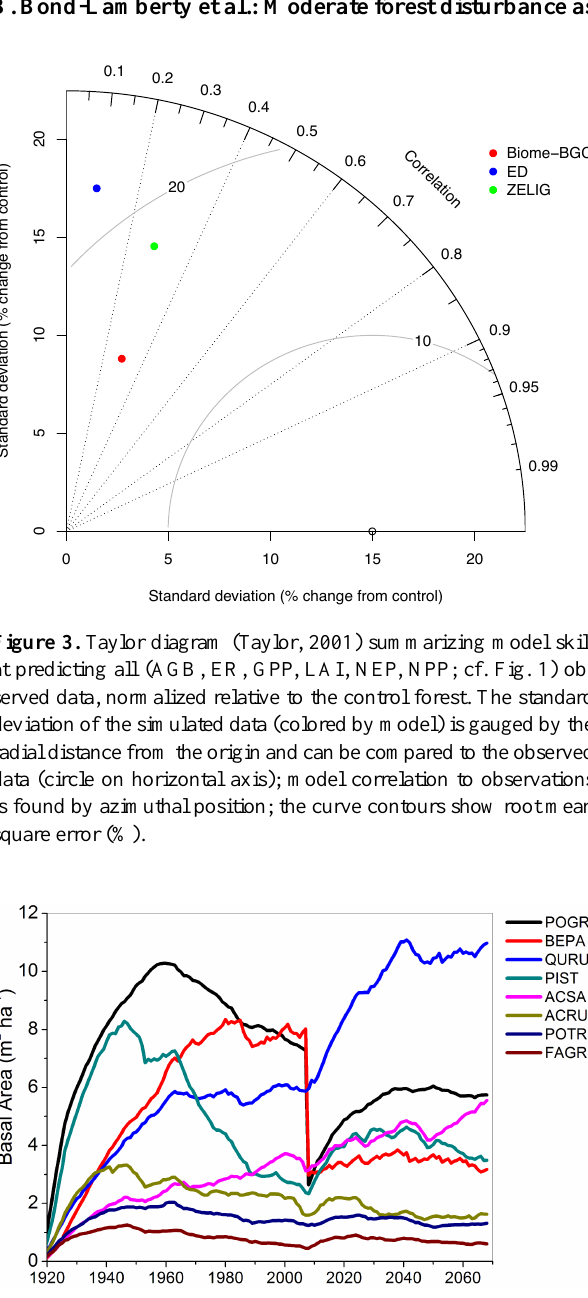
Figure 4. Species-specific basal area trajectories simulated by ZELIG, before and after the 2008–2010 tree removals mimicking the FASET experiment. Species codes are as in Table